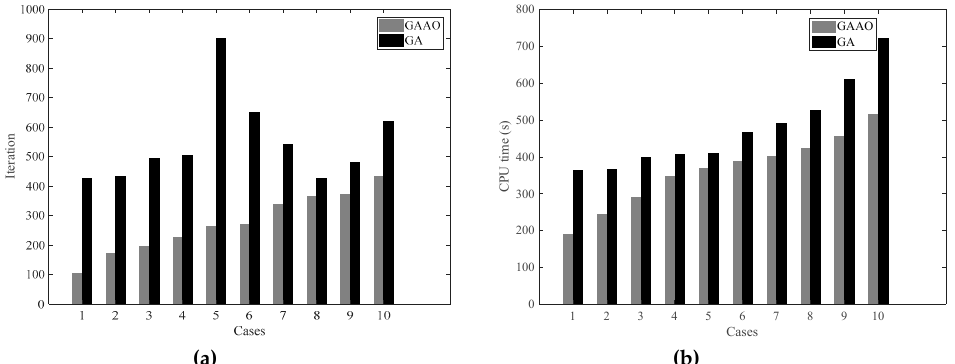
Figure 6. Comparison of computational performance between GA (genetic algorithm) and GAAO (genetic algorithm with adaptive operators). ( a ) Comparison of iteration between GA and GAAO; ( b ) Comparison of CPU time between GA and GAAO.